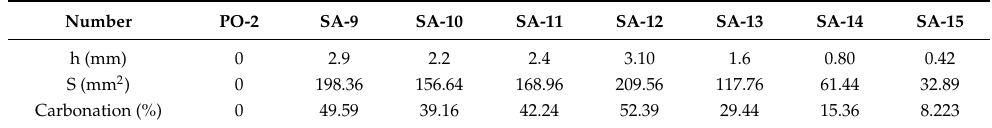
Figure 7. PO-2, SA-9–SA-15 after carbonation with 1% concentration of phenolphthalein indicator. Table 7. Carbonation depth and carbonation area of PO-2, SA-9–SA-15.